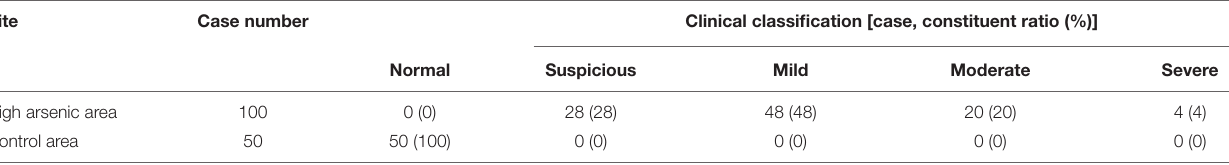
FIGURE 4 | Selenium content of hair, urine, and serum in Ziyang County and the control area. Data are represented by median (M) and quartile range (QR). The comparison was performed by the non-parametric rank-sum test. *, **** p < 0.05 and 0.0001, respectively. TABLE 1 | Clinical classification of arsenic poisoning in